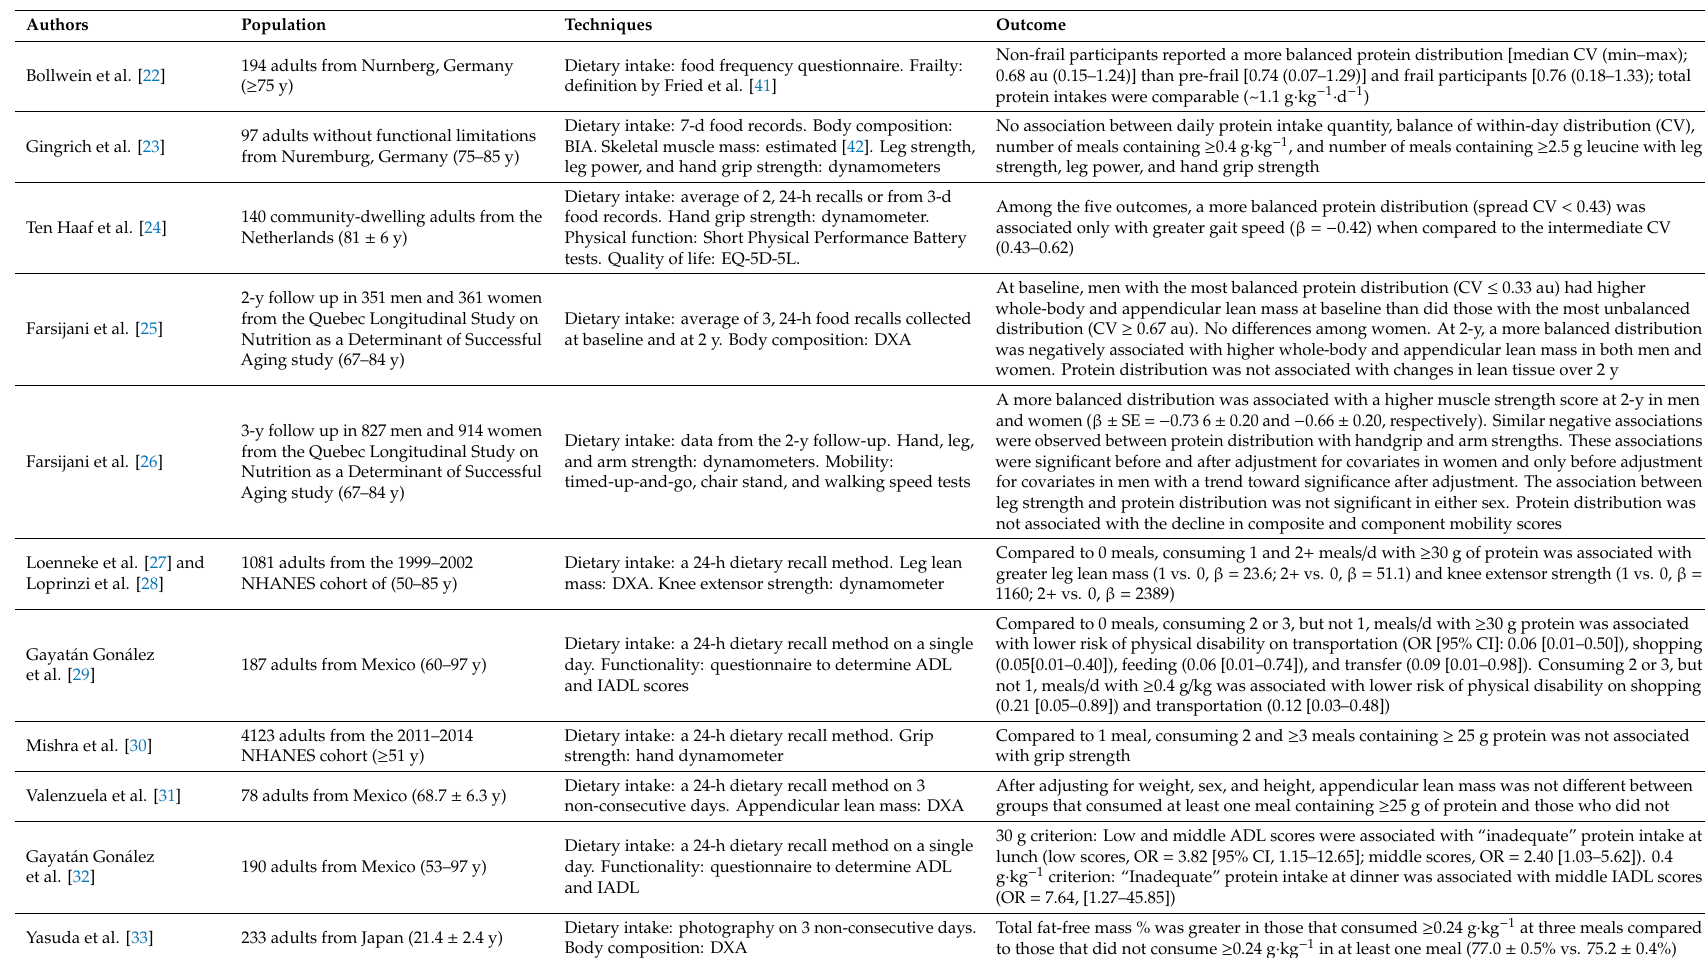
Table 1. Observational study characteristics.